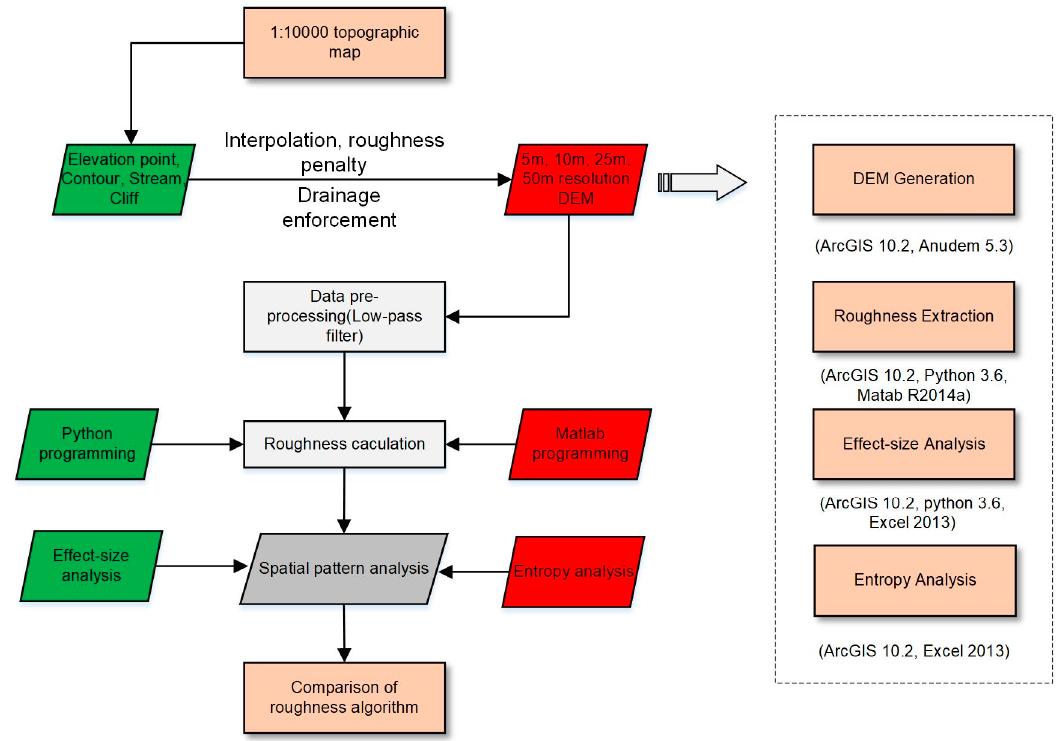
Figure 2. Data processing flow chart.